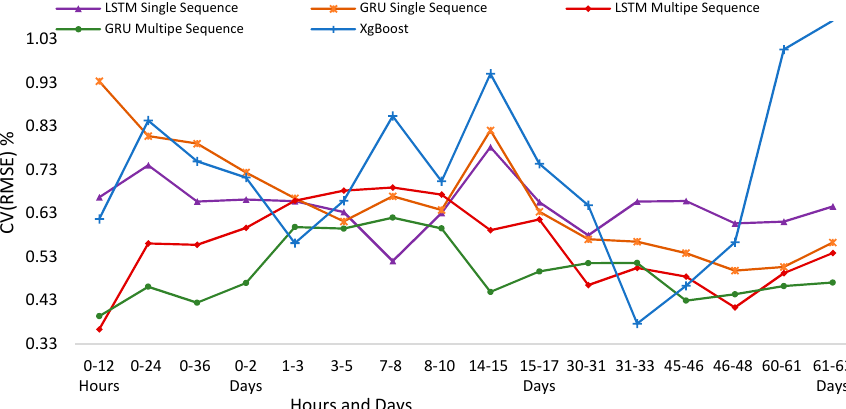
Figure 18. Forecasting Horizon for Machine Learning and Deep Learning Models.